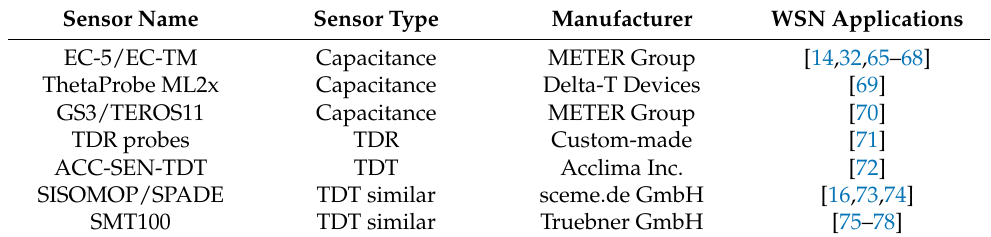
Table 2. Examples of soil moisture sensors commonly used in WSN